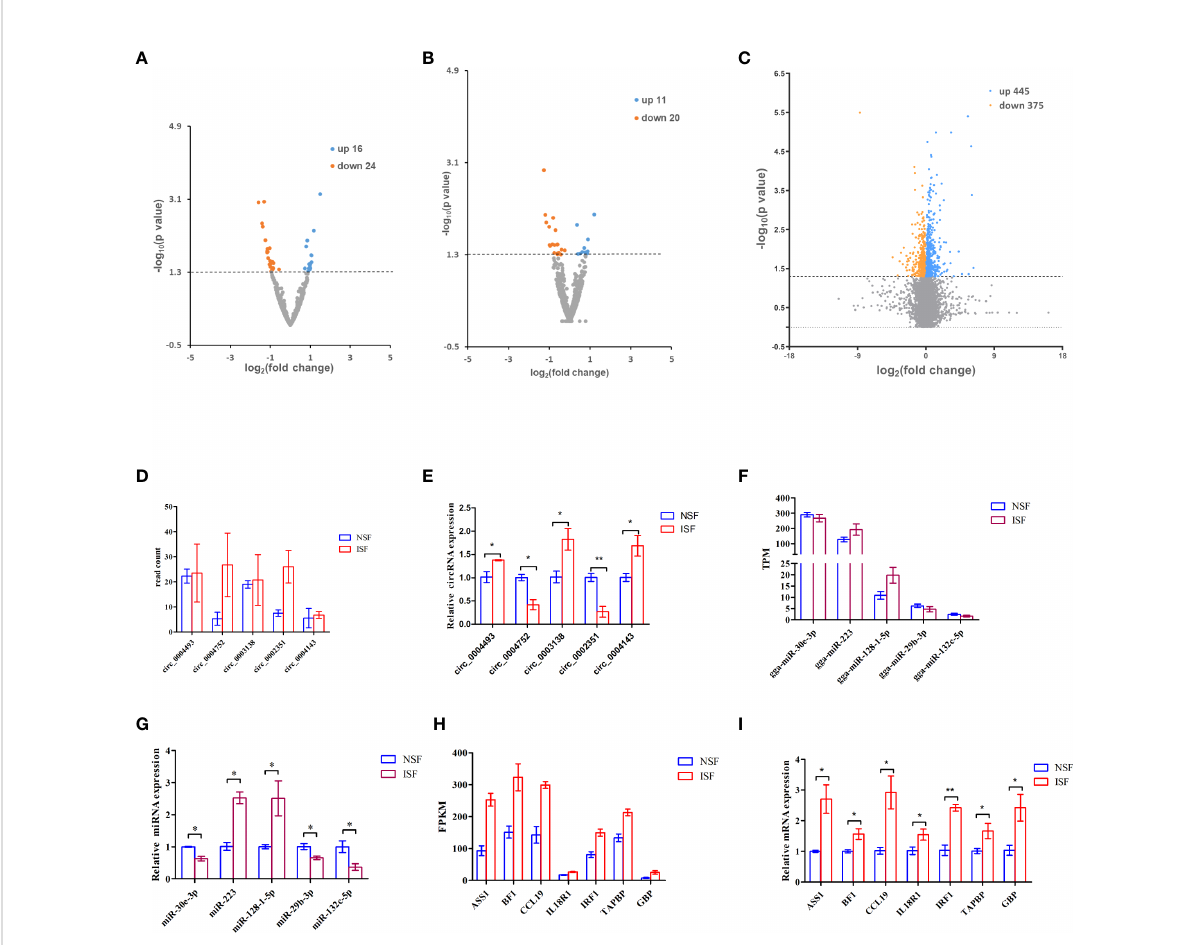
FIGURE 1 Volcano map of differentially expressed circRNAs, miRNAs and mRNAs associated with E. tenella infection. (A) Volcano map of differentially expressed circRNAs . (B) Volcano map of differentially expressed miRNAs. (C) Volcano map of differentially expressed mRNAs. For (A-C) , threshold used to de fi ne differentially expressed genes is(fold change)> 0 and P < 0.05. (D) Read count of the selected DEcircRNAs from the sequence data. (E) RT-qPCR quanti fi cation of the selected DEcircRNAs . (F) TPM of the selected DEmiRNAs from the sequence data. (G) RT- qPCR quanti fi cation of the selected DEmiRNAs . (H) FPKM of DEmRNAs from the sequence data. (I) RT-qPCR quanti fi cation of the selected DEmRNAs . For D-I, results are shown as mean±SEM. Statistical signi fi cance of differences between means was assessed using unpaired Student ’ s t-test. (* P <0.05; ** P